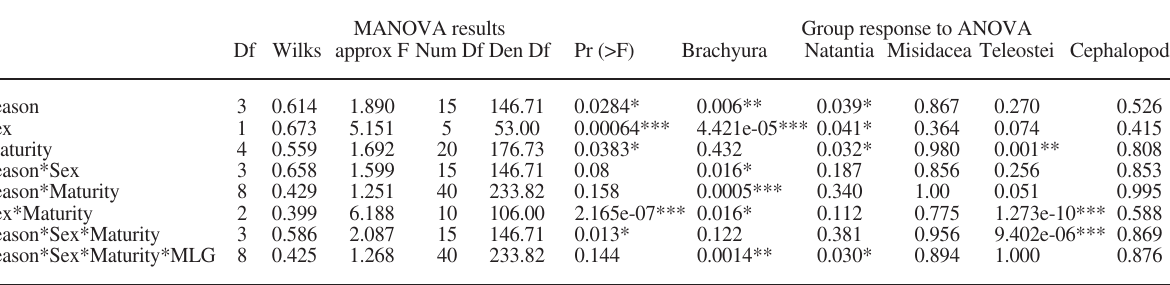
Table 4 . – Manova table of Wilks’ lambda and group response to anova. (df = degrees of freedom; Wilks = value of Wilks statistic; approximate F = approximate F value; num df = numerator degrees of freedom; den df = denominator degrees of freedom; Pr (>/F) = p